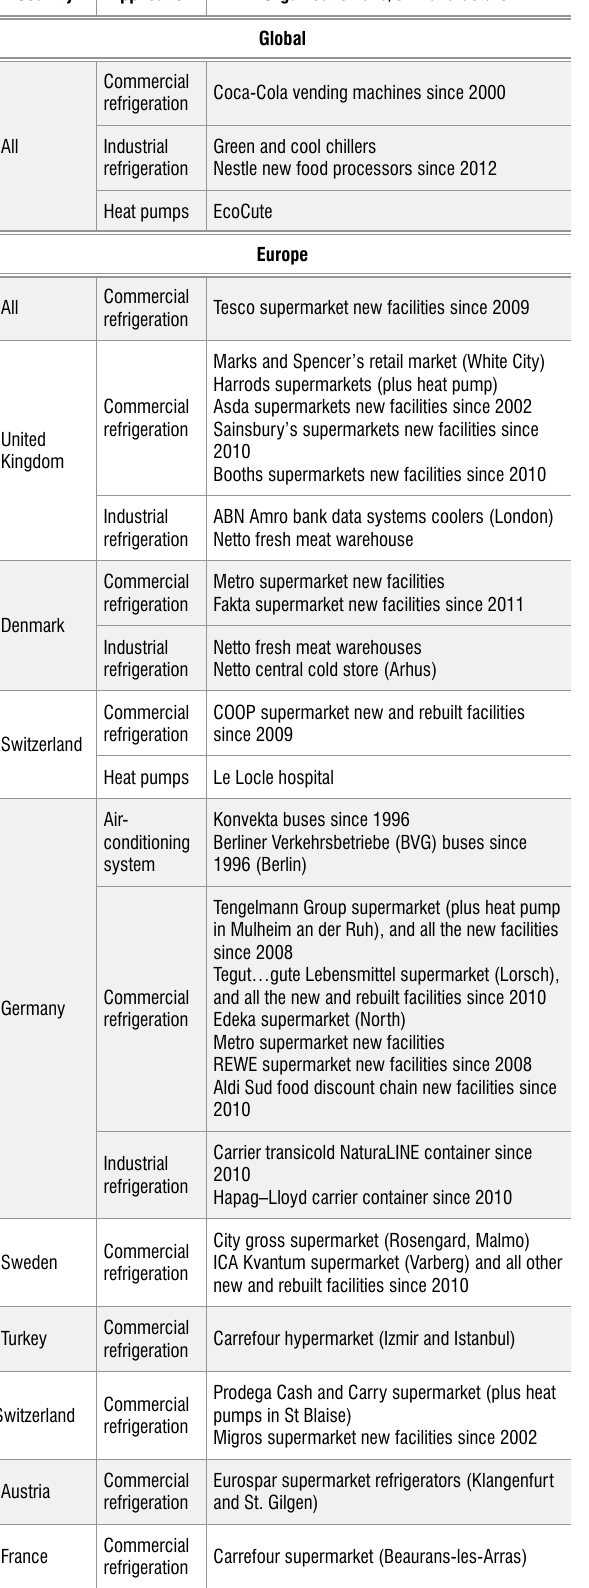
refrigeration 1,23,39-42 3